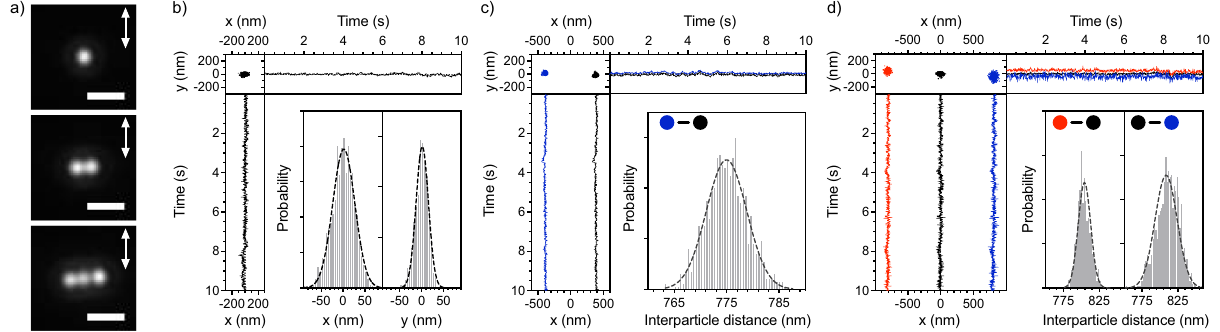
Fig. 2 | One to three Au NPs systems. a Representative images for the three studiedsystems. The white scale baris 2 μ m, and the arrows indicate the direction of the laser linear polarization. b – d Spatial distributions of one ( b ), two ( c ) and three ( d ) trapped AuNPs (400nm in diameter) at the glass/solution interface. The trapping laser is linearly polarized in the y-direction. (Upper left): The two- dimensional distribution in the x-, y-focal plane and their trajectories, in x- and